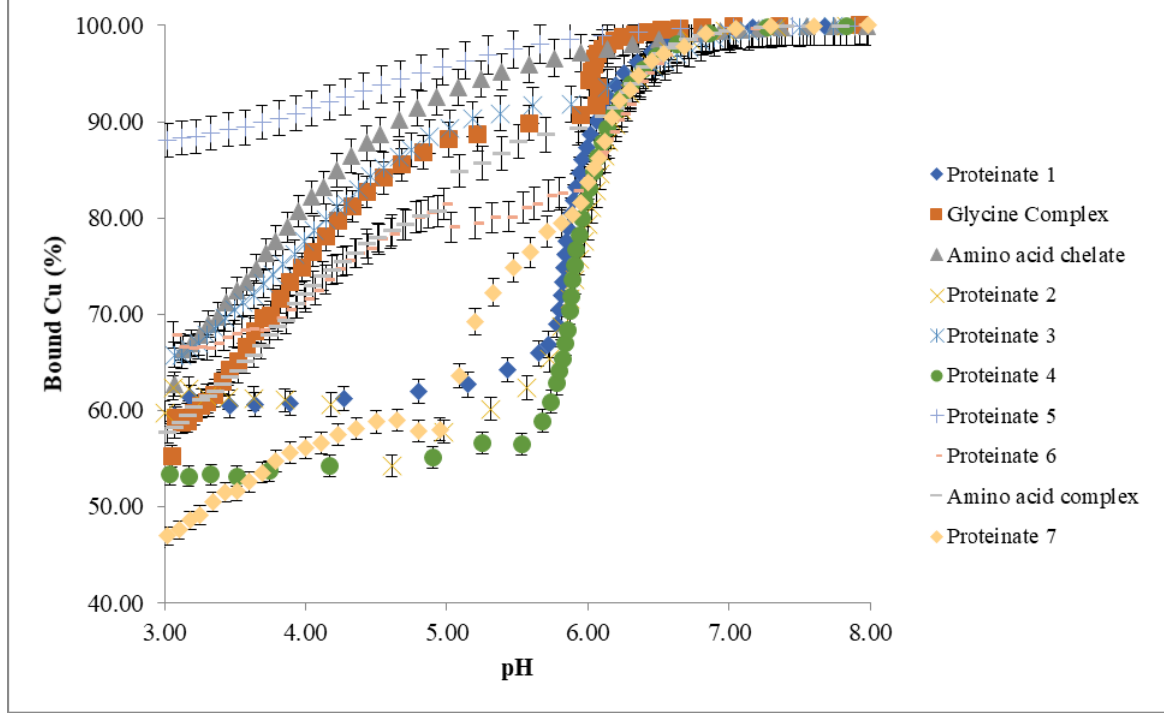
Figure 8. ISE titrations ( n = 3) of commercial copper